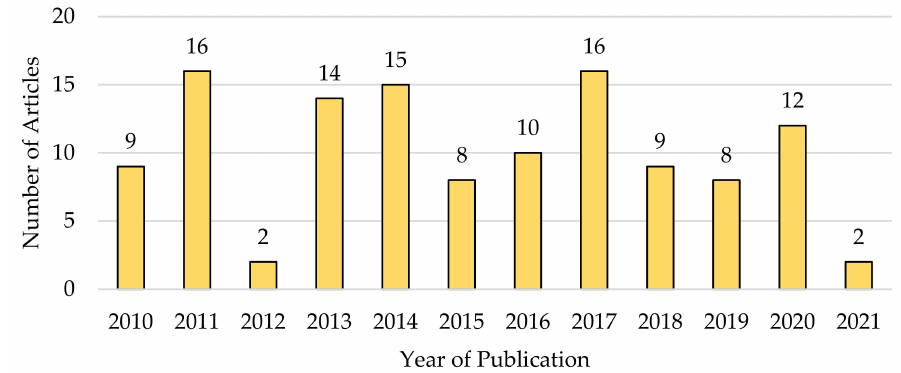
Figure 3. Number of relevant articles published between 2010 and 2021.